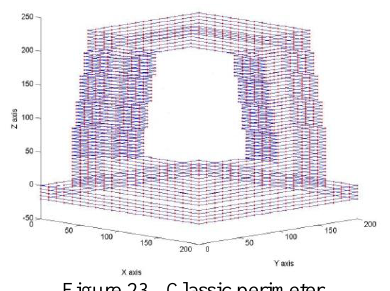
Figure 23. Classic perimeter